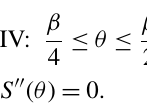
The phase angle functions are plotted in Fig. 10. The nor- malized S , V , A , J , and A × V functions are illustrated in Fig. 11. The synthesized motion (MCV50 P ) is a solid line, and modified constant velocity 50 motion (MCV50) is a dashed line. The motion characteristics of the correspond- ing functions are listed in Table 5. The average reduction in all motion characteristics is 0.30 %. Notice that the reduction percentage of the value f c is quite close to that of Example 2. However, the reduction in the value of C V is not as